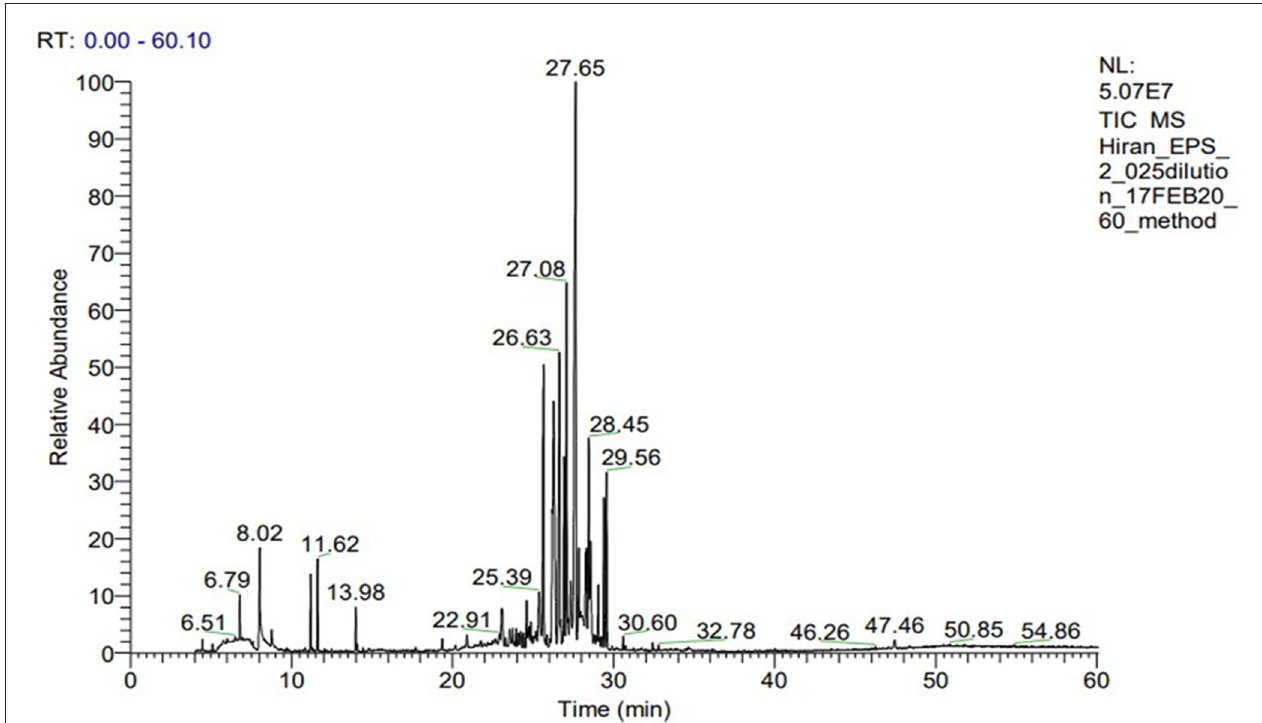
FIGURE 3 | GC-MS spectra of heteropolysaccharide from C . alatae LCS1 showing monosaccharide compositions at different retention times.